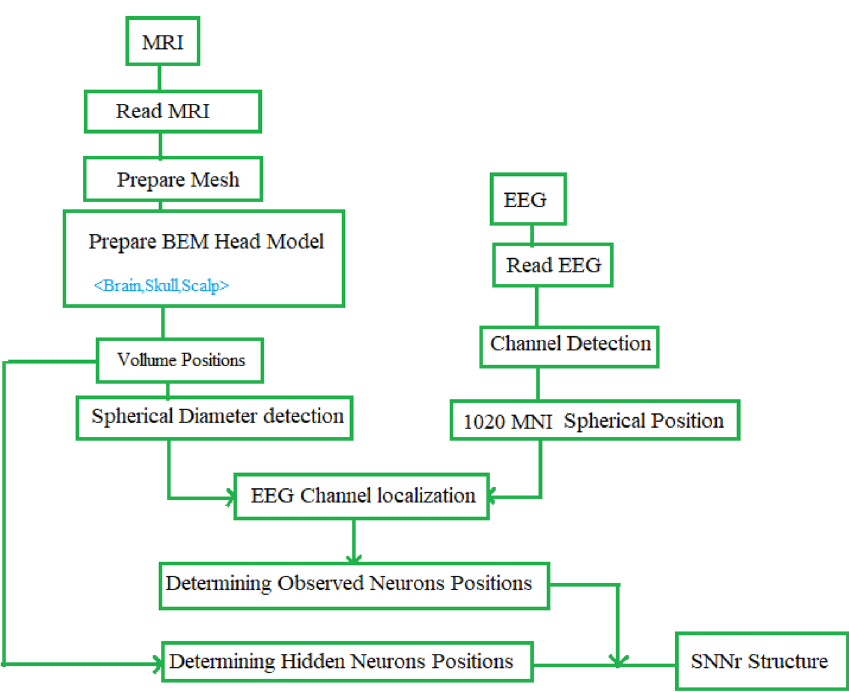
Figure 2. The Algorithm of Combining MRI and EEG data to calculate the positioning of the neurons in the 3D MRI-SNNr